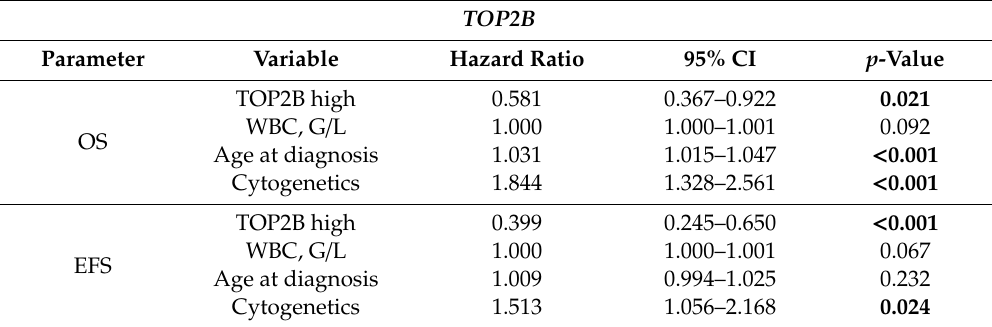
Figure 7. Expression of TOP2B in primary AML patient specimens. ( A ) Box plots displaying TOP2B mRNA expression levels in 24 paired AML patient specimens collected at the stage of diagnosis (Dg) and relapsed / refractory disease (R / R). miR-23a expression levels were analyzed by qPCR and are displayed as the log-transformed x-fold expression of the calibrator (NB4 cells). The p -value has been calculated using the Wilcoxon signed-rank test. ( B , C ) Overall survival ( B ) and event-free survival ( C ) in AML patients treated with AraC-containing high-dose regimens (n = 154) according to the TOP2B expression status. Data were downloaded from the TCGA-AML dataset [35], and re-analyzed for the expression of TOP2B . Statistical significance was calculated by Cox regression analysis. Table 2. Multivariate Cox regression analysis for EFS and OS. Statistically significant values are indicated in bold. EFS, event-free survival; OS, overall survival; CI, confidence interval; WBC, white blood cells; G / L, giga per